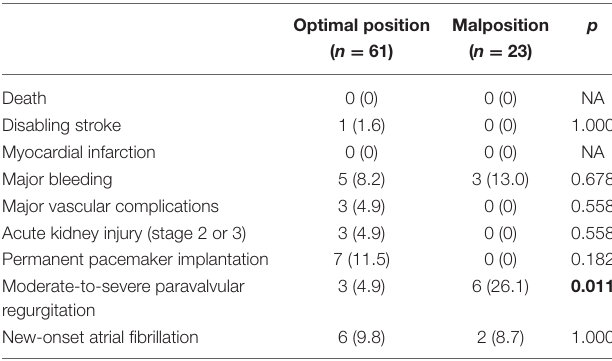
TABLE 5 | Clinical outcomes at 30 days after